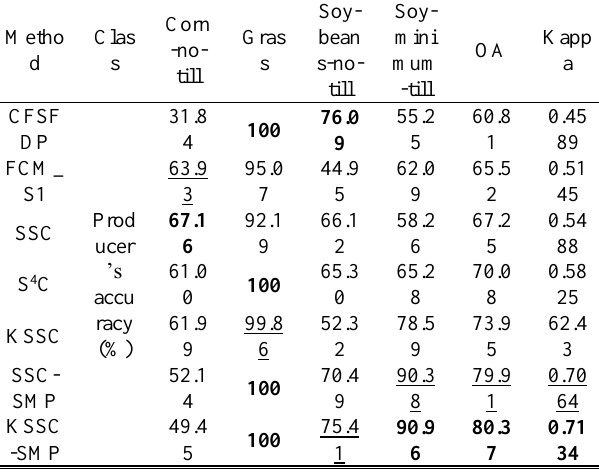
Table 1. Quantitative Evaluation of the Different clustering Algorithms with the Indian Pines Image.